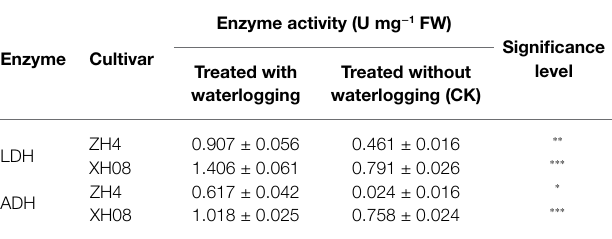
TABLE 3 | ANOVA analysis of the enzymatic activities (U mg − 1 FW) of ADH and LDH in XH08 and ZH4 treated with and without waterlogging after 12 days.